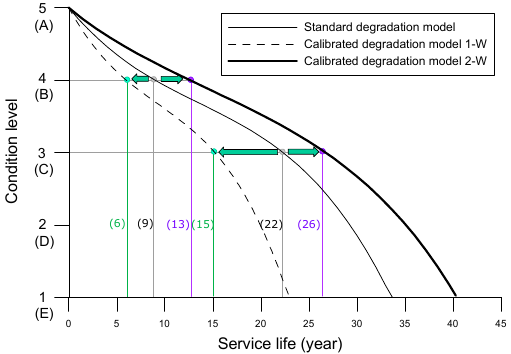
Figure 4. Example of a calibrated performance degradation model. Table 6. Condition level of an RC slab and PSC-I girder (inspection type 1).